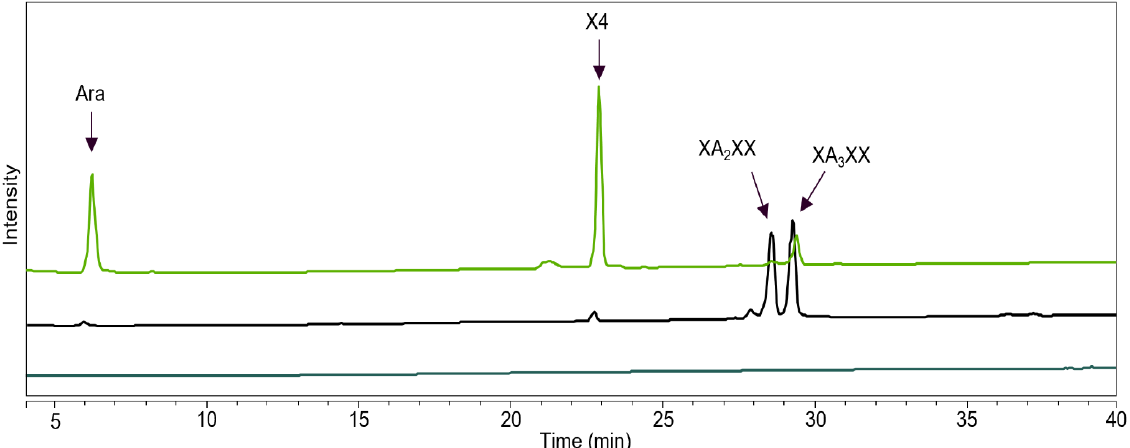
Figure 7. HPAEC profiles of a mixture of XA 2 XX and XA 3 XX (xylotetraose O -2 and O -3 monosub- stituted on the second xylosyl from the non-reducing end, respectively) incubated with Hi- ABF43_36a (green), without enzyme (substrate blank) (black), and with Hi ABF43_36a but without substrate (enzyme blank) (dark green). Incubation contained 25 µ g mL − 1 enzyme and 100 µ g mL − 1 XA 2 XX/XA 3 XX mixture. Reaction conditions are displayed in Section 4.2.2, exp. # 2.